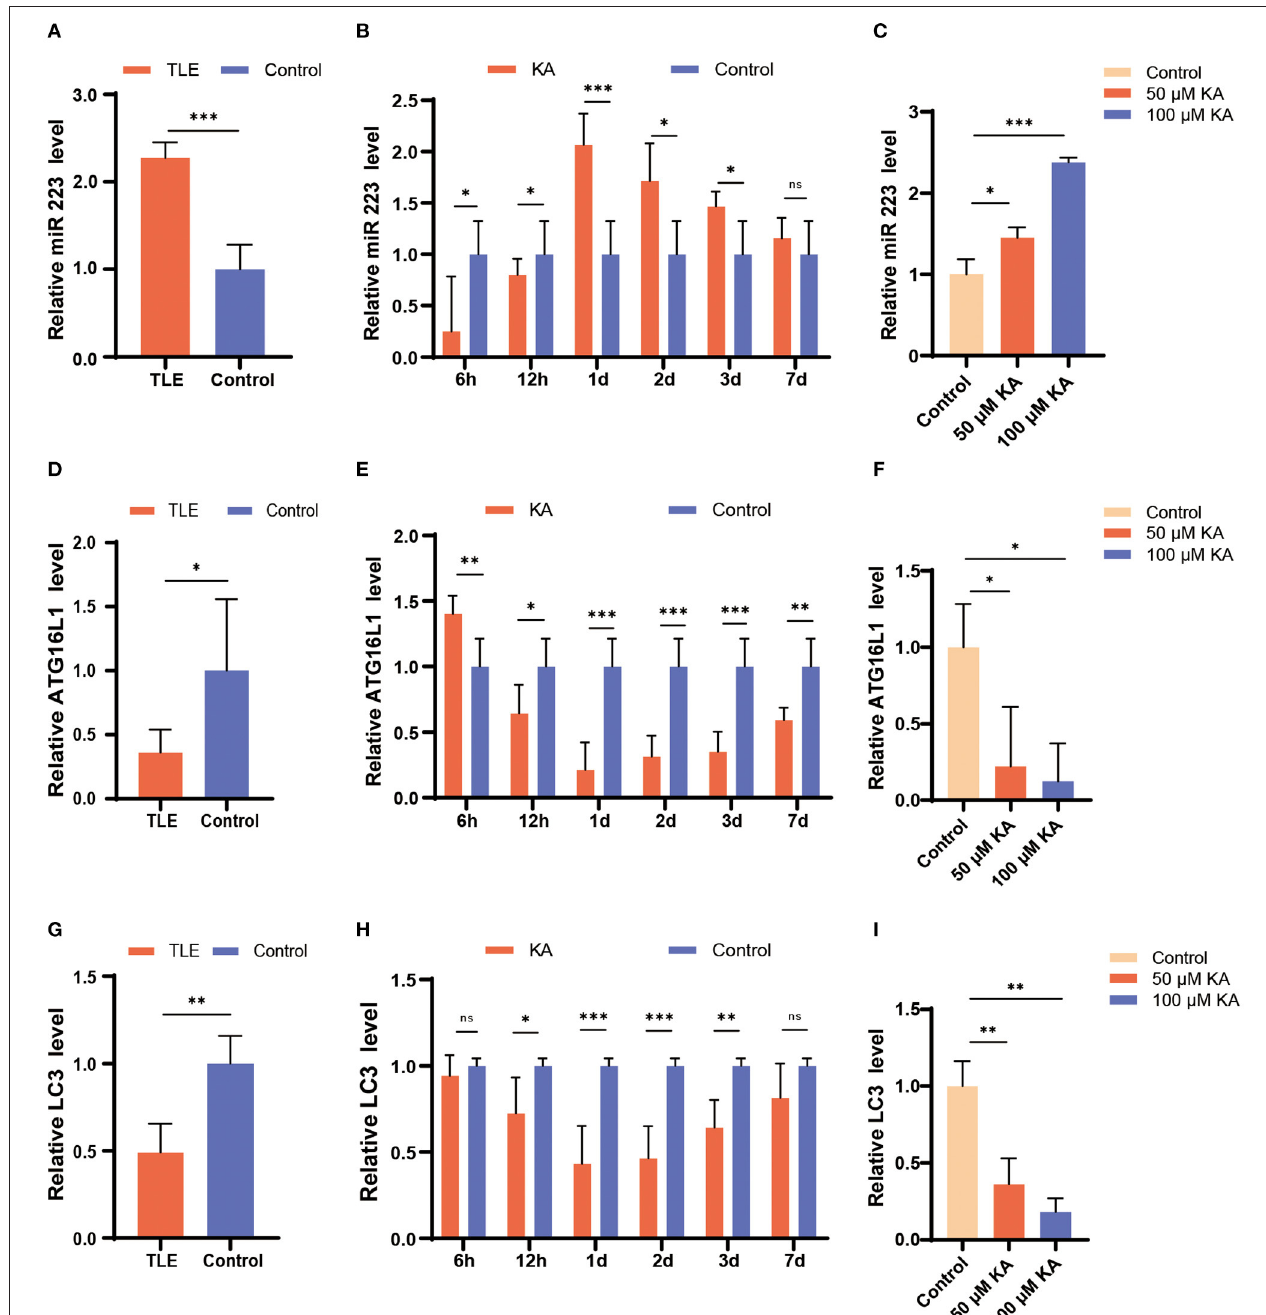
FIGURE 1 | Changes in miR 223, ATG16L1, and LC3 expression patterns in TLE patients, the mouse TLE model, and BV2 cells. (A) Specimens from patients with TLE ( n = 10) and controls ( n = 5) were analyzed for miR 223 levels. (B) C57BL/6J mice were intracerebroventricularly injected with KA or saline and sacrificed at 6h, 12h, 1 d, 2 d, 3 d, or 7 d after the treatment. The mice hippocampal tissues were analyzed to assess the miR 223 levels using qRT-PCR ( n = 6 per group). (C) A BV2 cell line was treated with various concentrations of KA for 24h. The miR 223 levels in the cells were analyzed using qRT-PCR ( n = 3 per group). (D–F) qRT-PCR measurement of ATG16L1 mRNA levels in samples of TLE patients (D) , mouse hippocampal tissue (E) , and BV2 cells stimulated with KA (F) . (G–I) qRT-PCR measurement of LC3 mRNA levels in samples of TLE patients (G) , mouse hippocampal tissue (H) , and BV2 cells stimulated with KA (I) . Statistically significant differences were determined using the unpaired t -test. Data are presented as means ± SD ; * p < 0.05; ** p < 0.01; *** p < 0.001; ns, not significant. miR, microRNA; TLE, temporal lobe epilepsy; qRT-PCR, quantitative real-time polymerase chain reaction; SD, standard deviation; KA, kainic acid; ns, not significant; LC3, light chain 3.